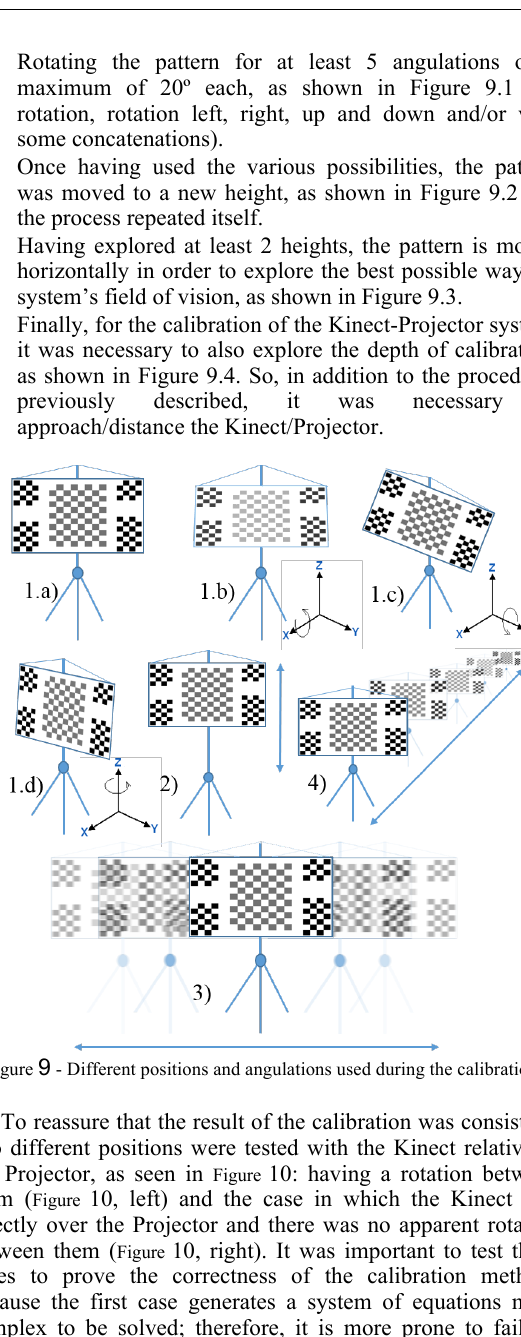
Figure 11 – Depth Mapping (A) and Colors